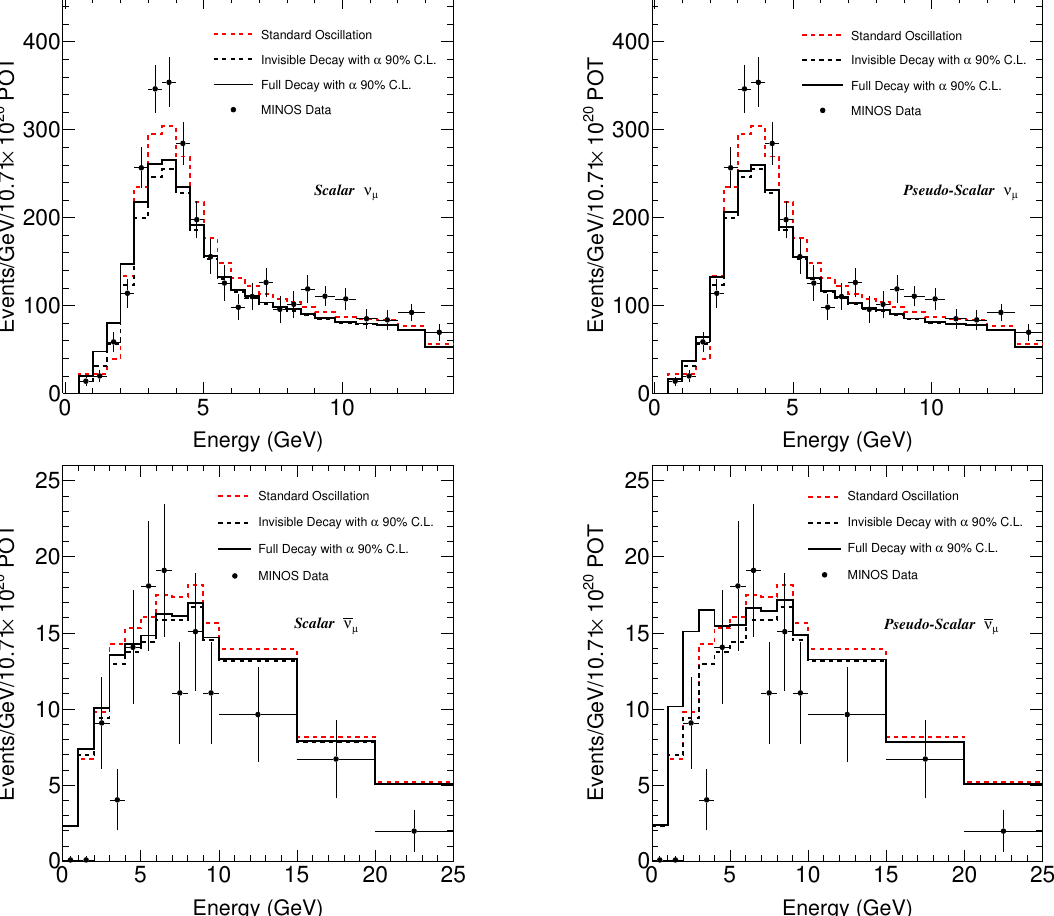
Figure 5 . The spectrum of muon and anti-muon neutrinos events is presented for the SO, ID and FD scenarios. We (cid:12)xed the oscillation paramenters in (cid:1) m 2 0 : 0243, and (cid:14) CP = 0. We also (cid:12)xed the decay parameter (cid:11) = 3 : 0 (cid:2) 10 (cid:0) 4 eV 2 and m light = 0 : 05 eV. The MINOS data points were taken from refs. [16,